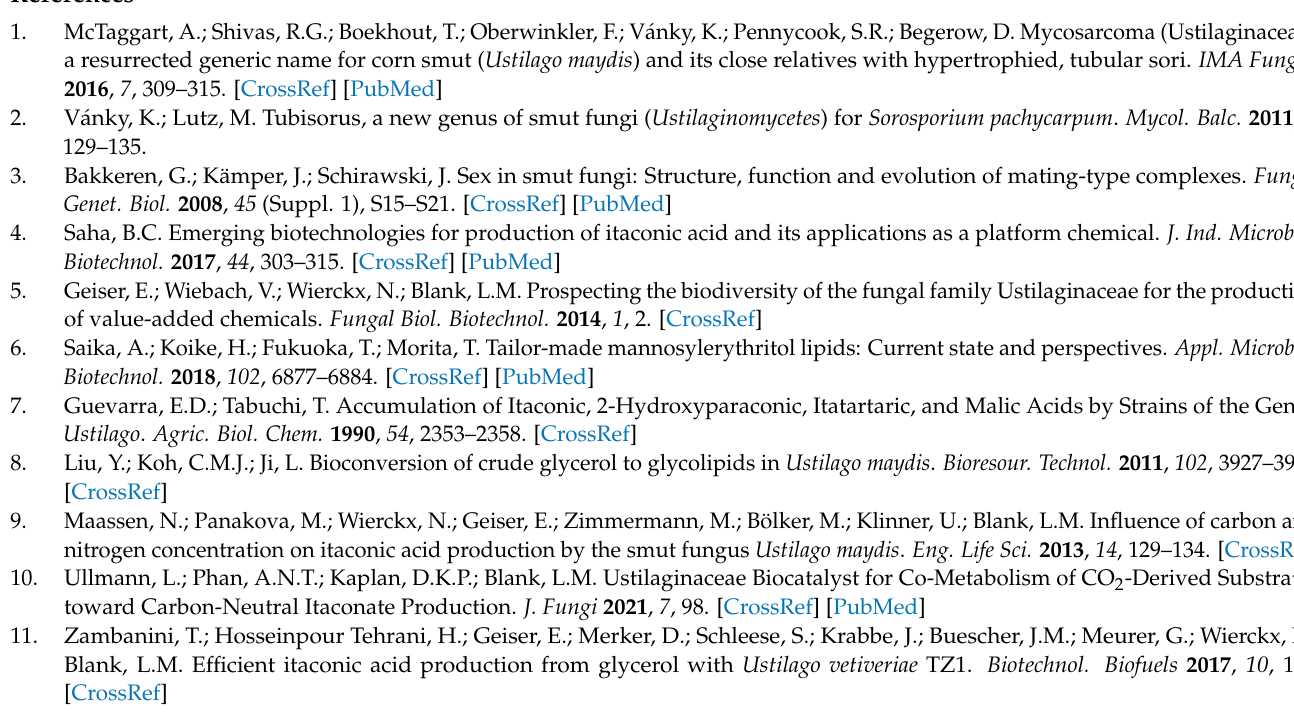
Figure S2: Controlled-batch fermentation of U. maydis No. 512, Table S1: Ustilaginaceae strains screened in this